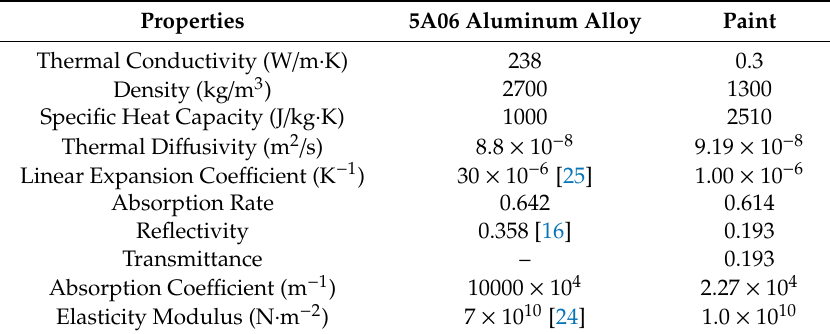
Table 2. Physical parameters of 5A06 aluminum alloy and paint